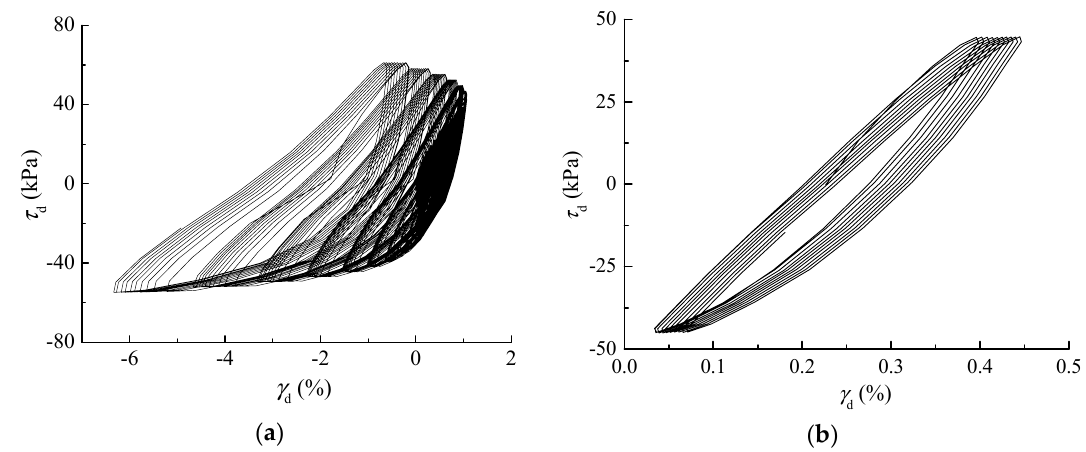
Figure 4. The stress–strain curves. ( a ) For all cycles and all loadings. ( b ) The cycles for the eleventh loading stage.